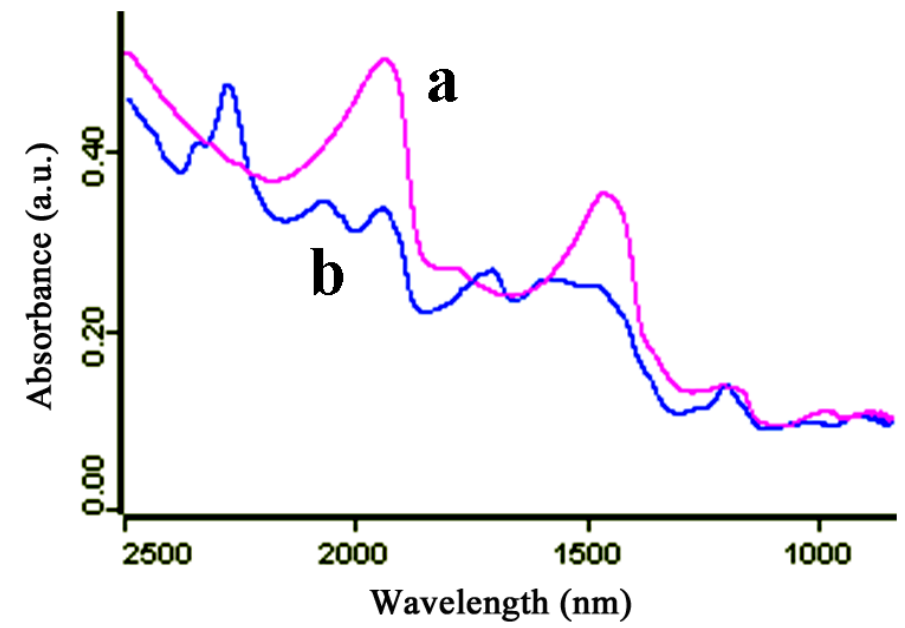
Figure 1. NIR spectra of amino-silica gel microparticles coupled with antibody ( a ) and amino-silica gel microparticles ( b